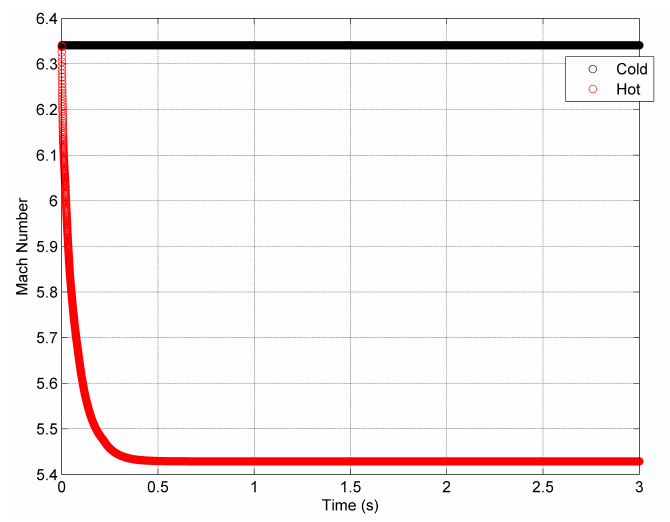
Figure 6. Change in flutter velocity with temperature from linear theory.